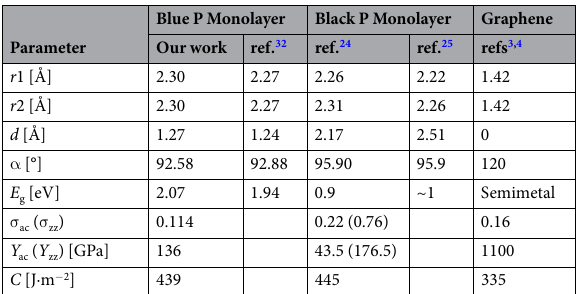
Table 1. Structural parameters of blue P monolayer, black P monolayer and graphene. The bond lengths ( r 1, r 2), puckered-layer distance ( d ), and bond angle ( α ) of the relaxed blue P monolayer are described in Fig. 1. σ σ ac ( Y ac ) and zz ( Y zz ) are the Poisson’ ratio (Young’s modulus) of slab along zigzag and armchair directions, respectively. Energy gap ( E g ) and in-plane stiffness ( C ) are